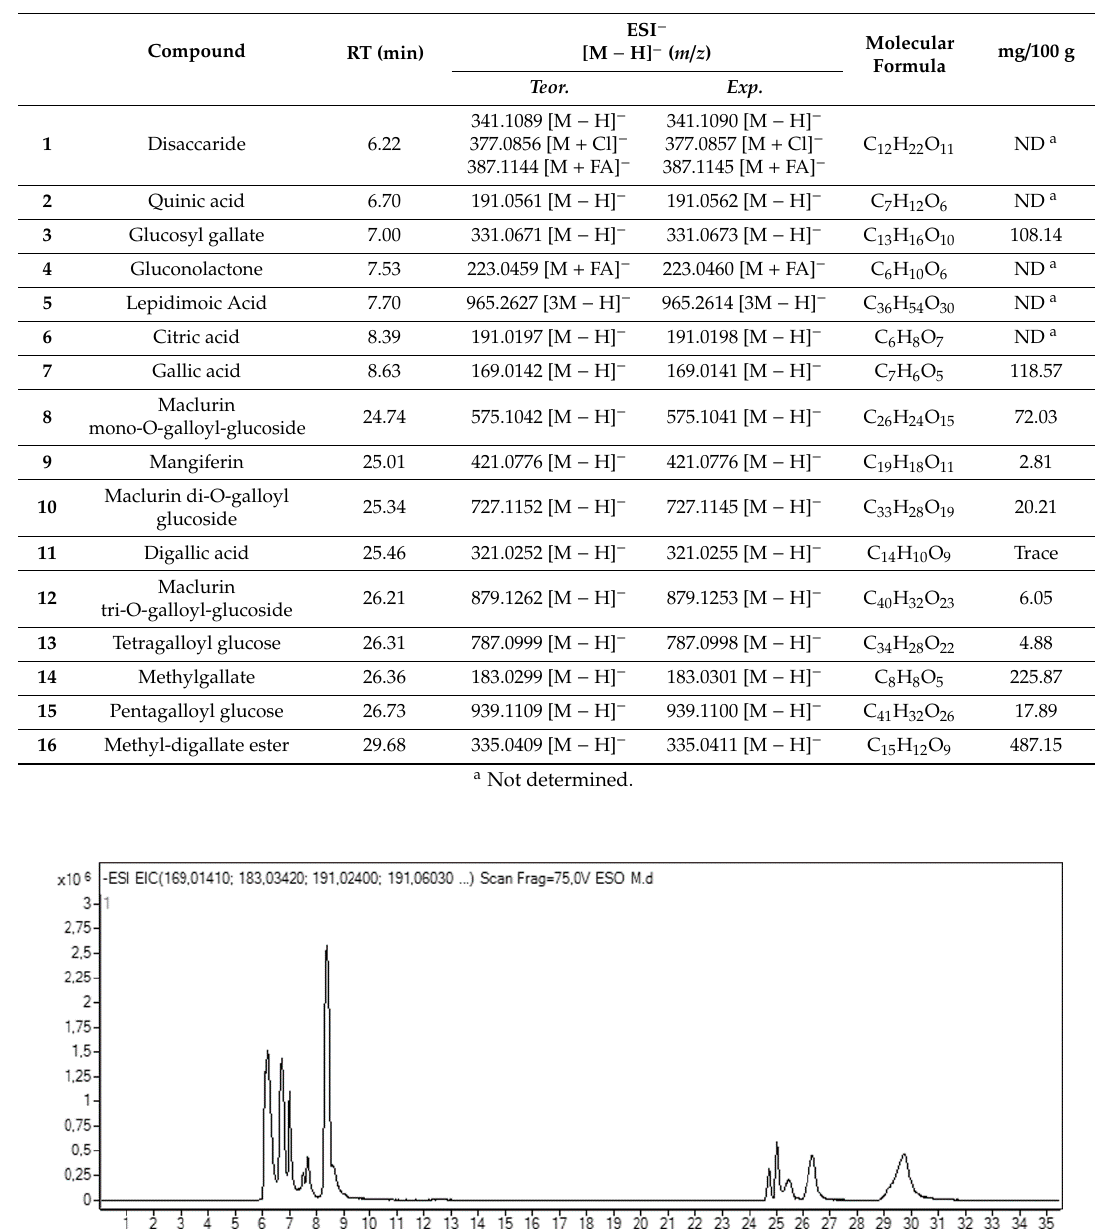
Table 1. Composition of mango peel extract (MPE).